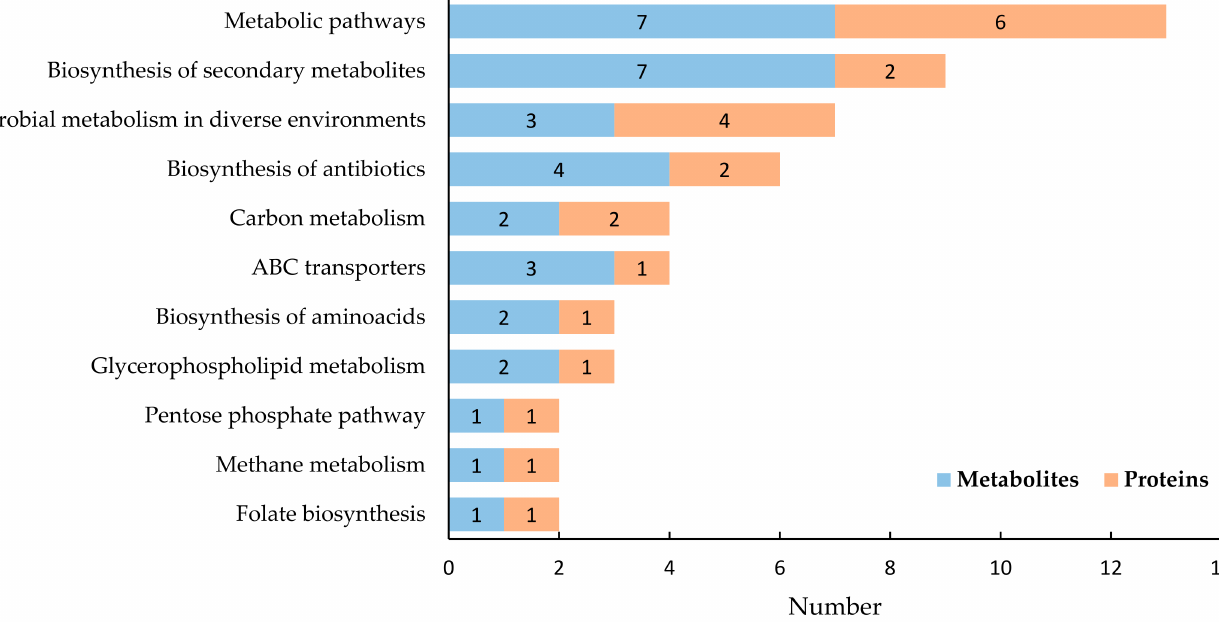
Figure 8. The KEGG pathways involving both the DEPs and DEMs in soybean rhizobia. Orange indicates the number of DEPs involved, and blue indicates the number of